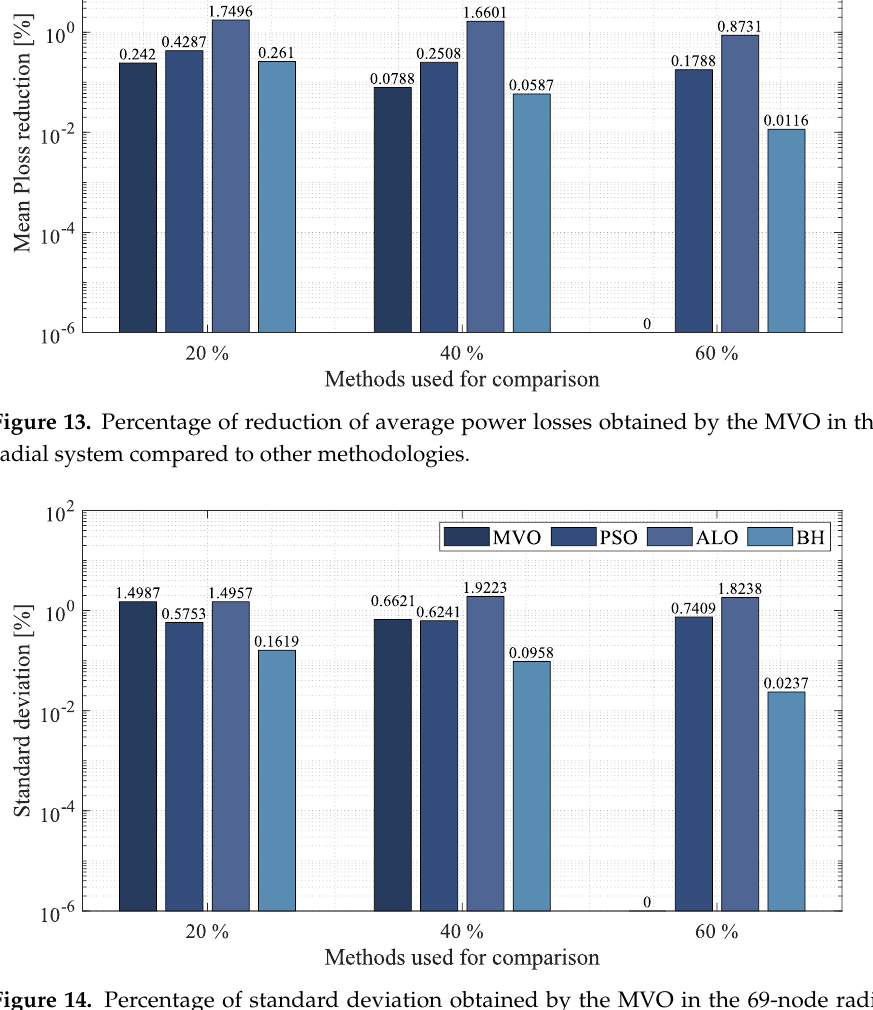
Figure 14. Percentage of standard deviation obtained by the MVO in the 69-node radial system compared to other